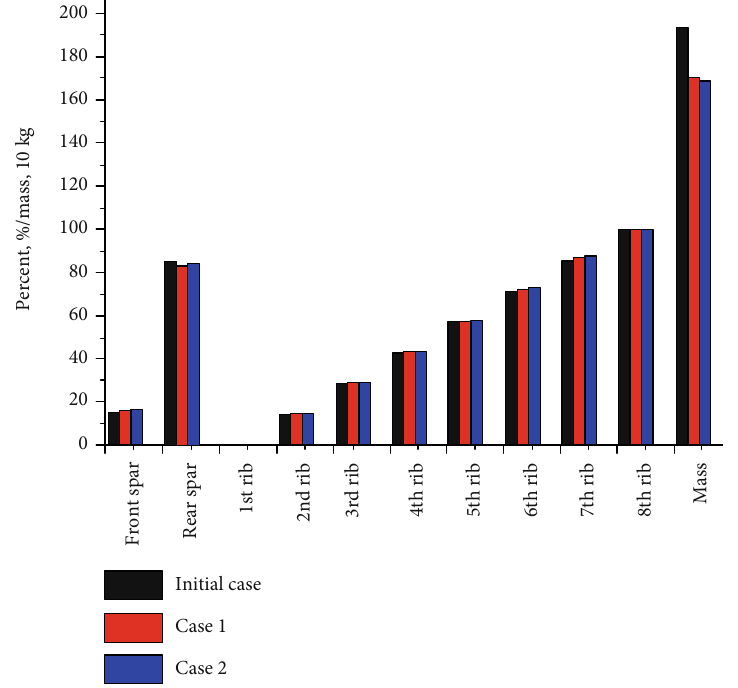
Figure 7: Comparisons of preoptimization and postoptimization conditions.